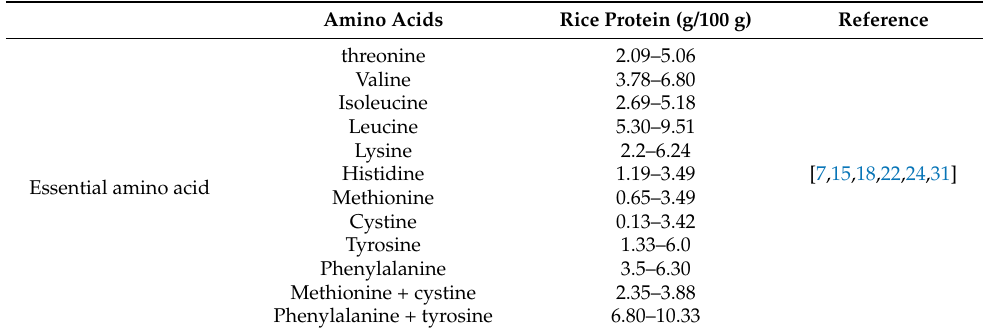
Table 1. The essential and non-essential amino acids present in rice protein and composition in g/100 g.